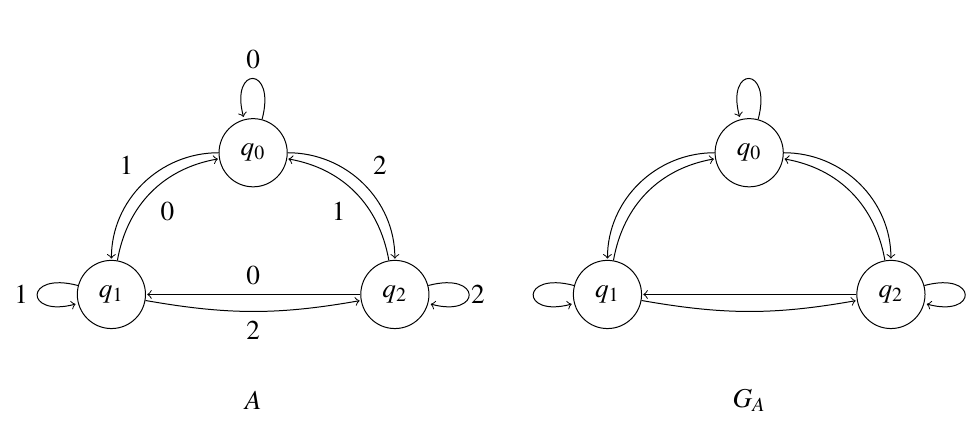
Figure 4: A folded automaton with an automorphism not induced by a